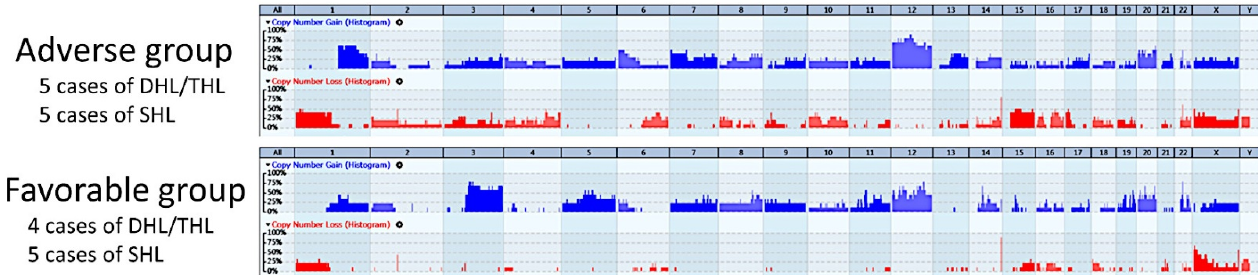
Figure A2. Copy number alterations of the adverse group and favorable group.